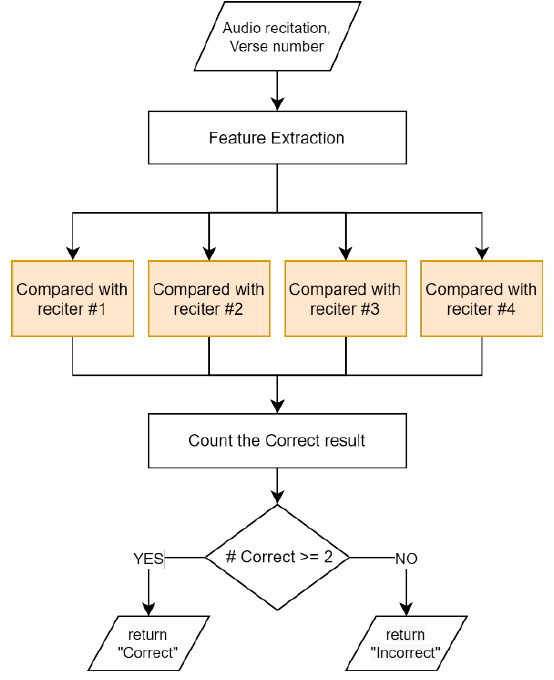
Fig. 5. Evaluation flow on inference set second